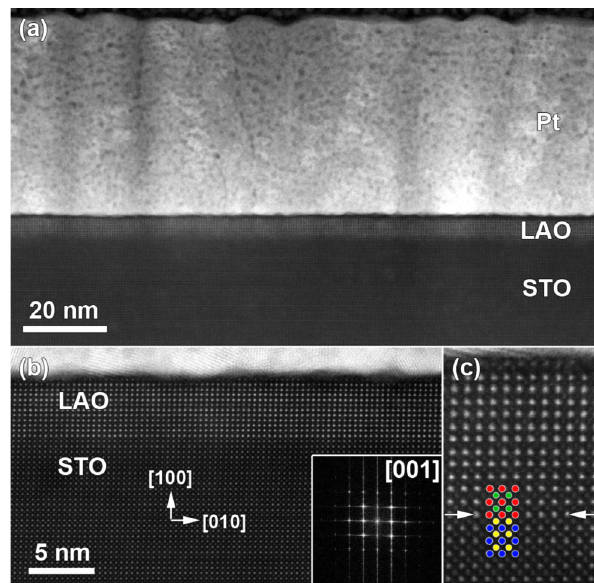
FIG. 2. (a) Overview and (b) high-resolution HAADF-STEM images of a Pt/LAO/STO heterostructure. A Fourier-transform pattern taken from the LAO layer and STO substrate simulta- neously confirms the cube-on-cube growth, imaged along the 001 zone axis orientation. (c) High-resolution image of the LAO/ STO interface, which is marked by arrows. In the atomic overlay, La positions are marked in red, Al in green, Sr in blue, and Ti in